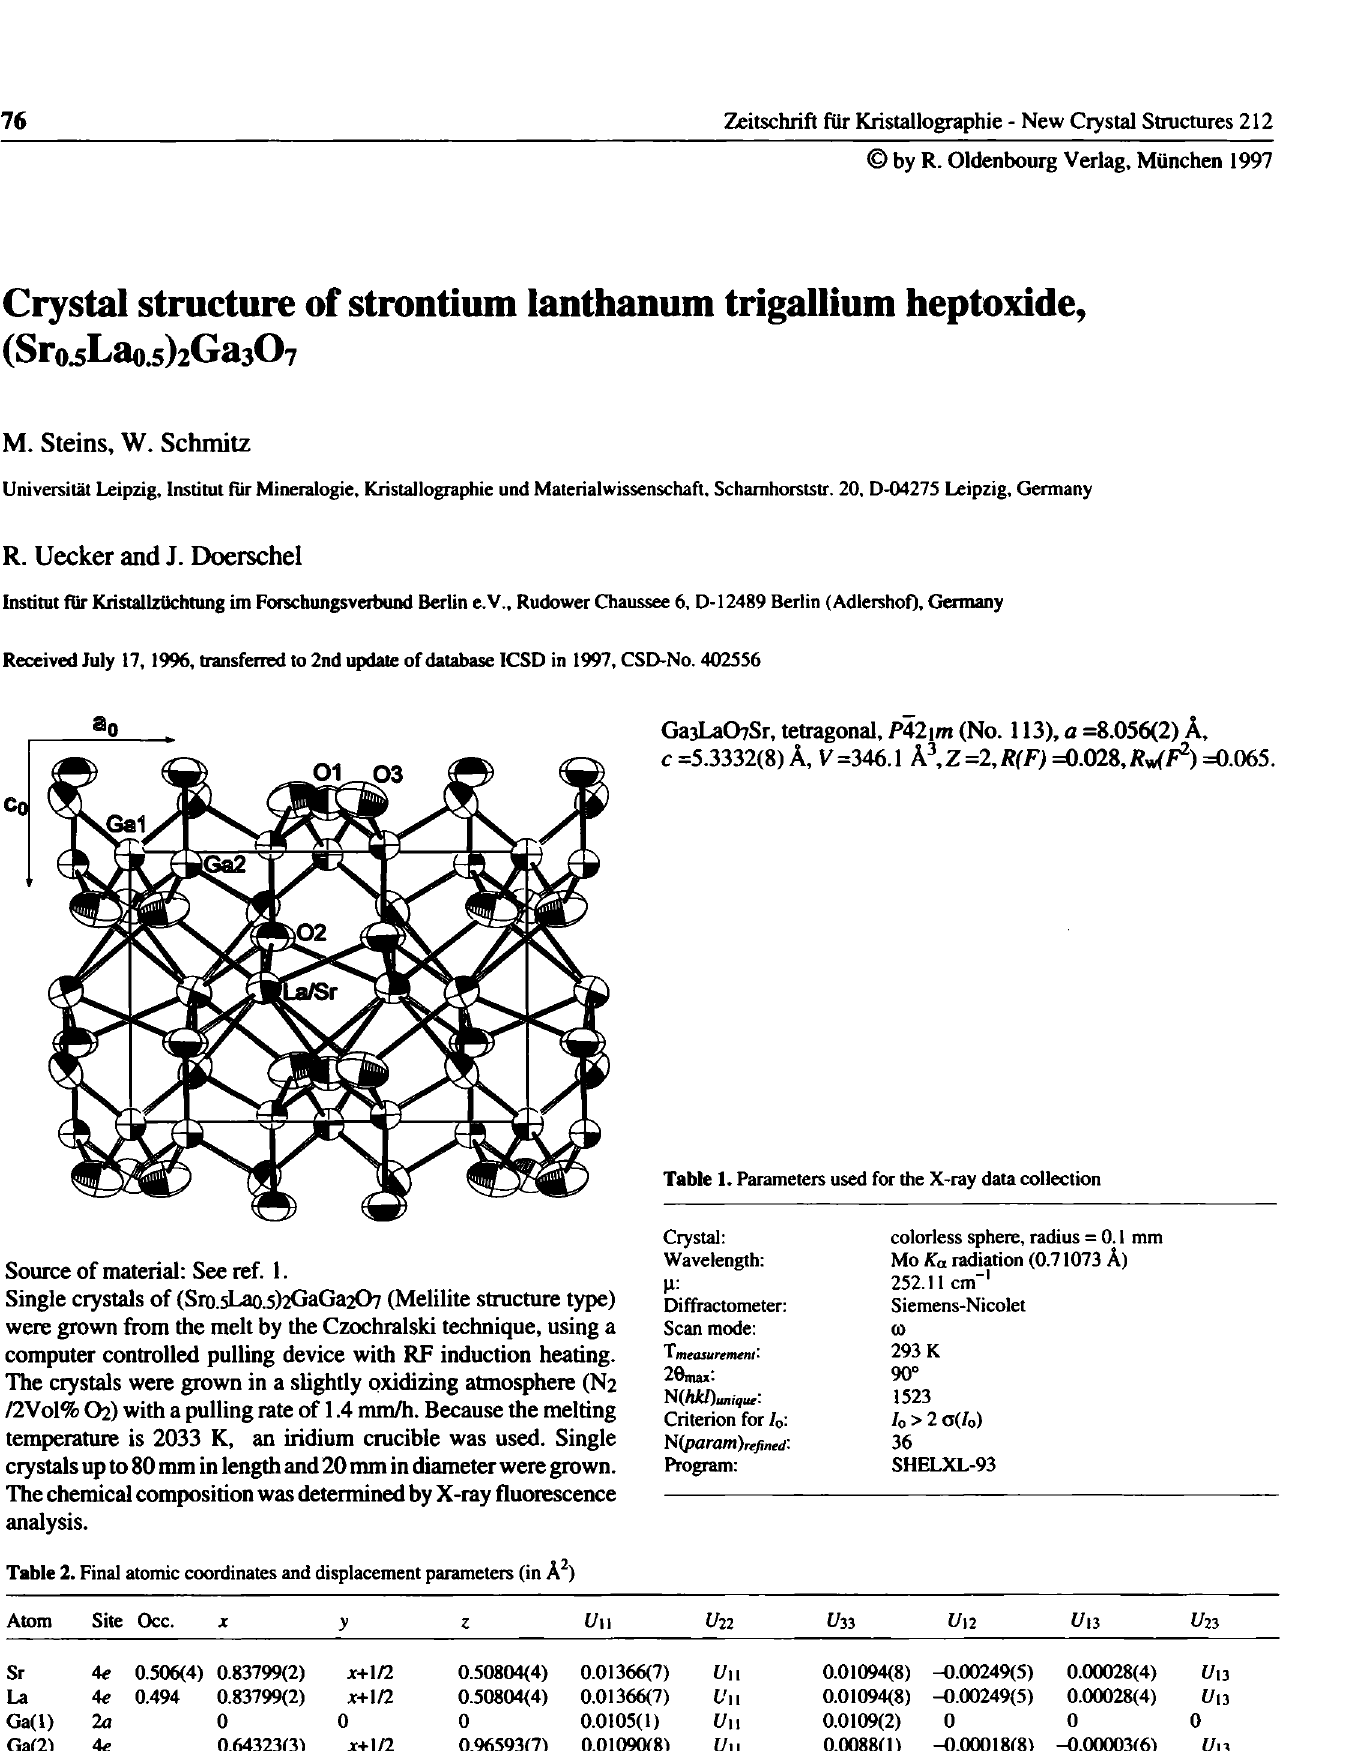
Table 2. Final atomic coordinates and displacement parameters (in À 2